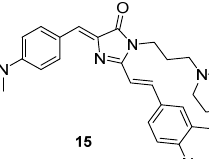
Figure 15. GFPc analogues used as molecular probe for imaging β -amyloids and lysosomes [29].